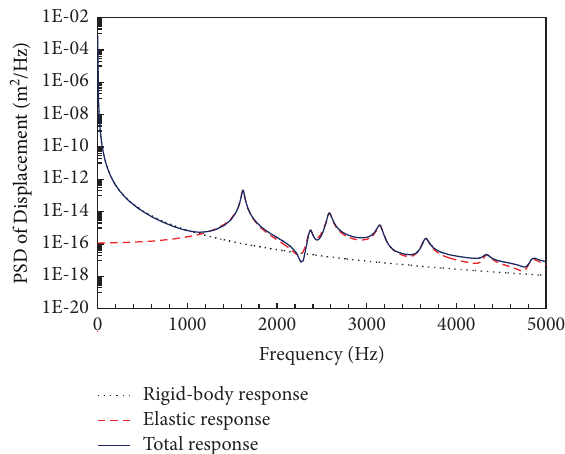
Figure 15: The PSD curves of fluctuating